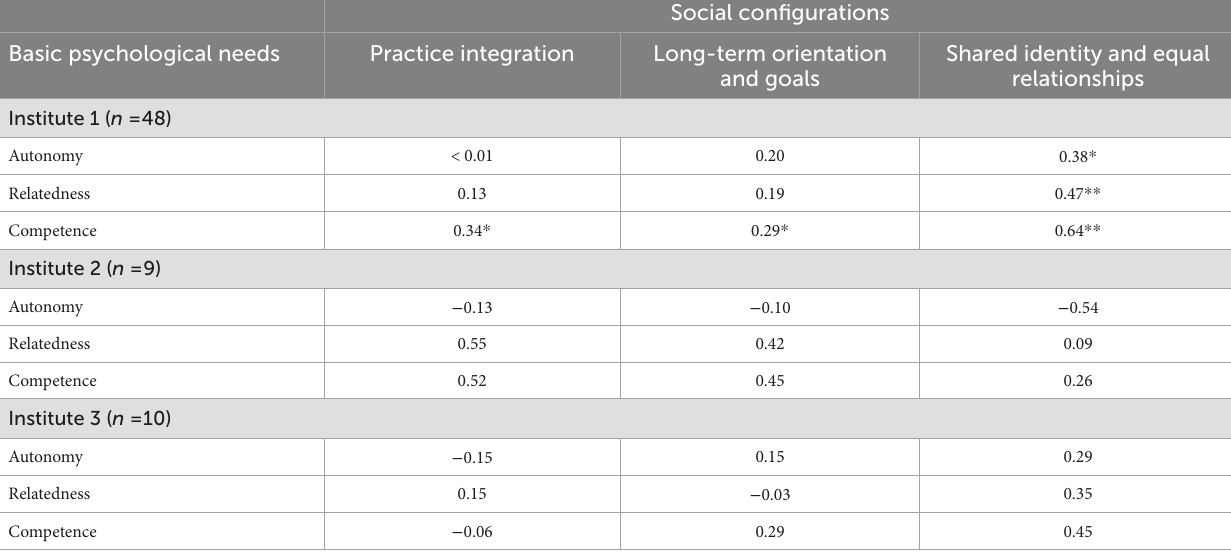
TABLE 8 The results of Kendall’s Tau-b test for social configurations and basic psychological needs per institute.